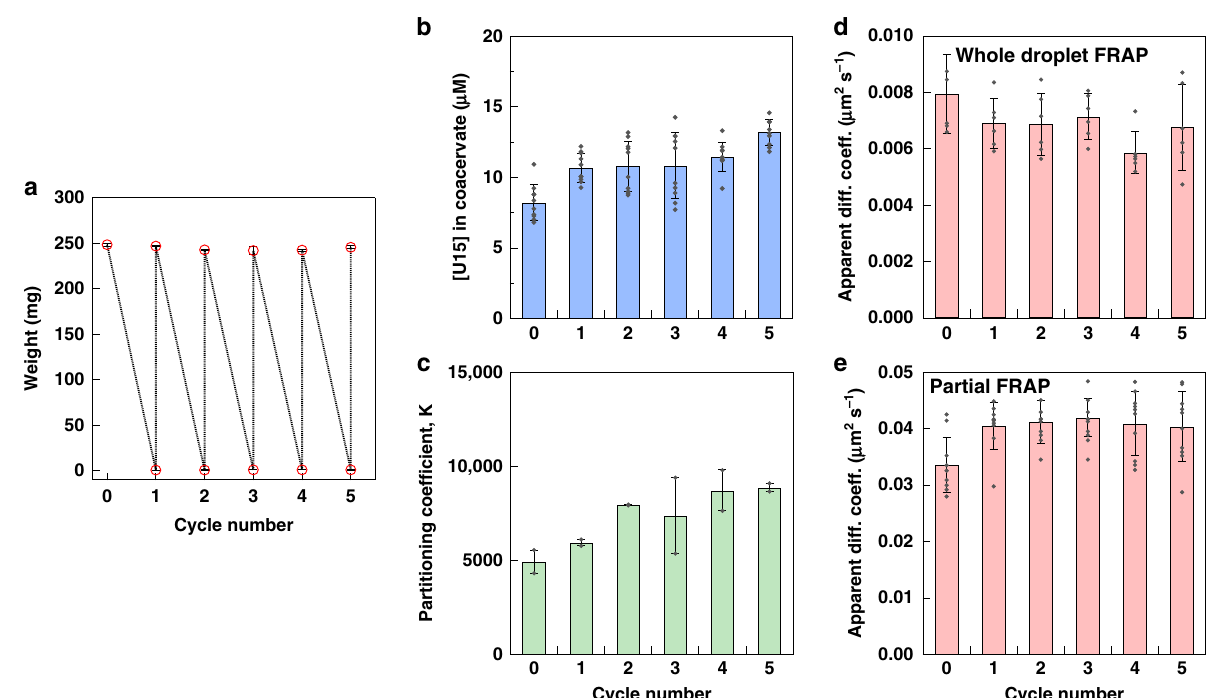
Fig. 4 Impact of repeating wet-dry cycles on the complex coacervate. a PDADMA/PAA coacervates ([Charge] = [NaCl] = 10 mM, [HEPES] = 5 mM, [MgCl 2 ] = 0.9 mM) were fully dried and rehydrated for fi ve consecutive cycles. The plot shows the average weights after drying-rehydration. b The concentration of U15 in the same coacervate after rehydration of samples obtained by confocal microscopy using Alexa 647-U15 as a probe. c The partitioning coef fi cient, K, taken as [U15] coacervate phase /[U15] dilute phase , after each cycle. d Apparent diffusion coef fi cients obtained from halftime of fl uorescence recovery during FRAP experiment where whole coacervate droplets, containing the Alexa 647-U15 probe, were bleached. e Apparent diffusion coef fi cients in FRAP experiments where a 1- µ m diameter region within the coacervate phase was bleached. The data in b – e are averages and standard deviations of two trials with an analysis of 10 droplets total for b , with the same values used when dividing by the [U15] in the dilute phase in c , six droplets in d , and 10 intradroplet areas in e . Individual data points are shown as gray markers. Supplementary Tables 5 and 6 include all FRAP fi tting